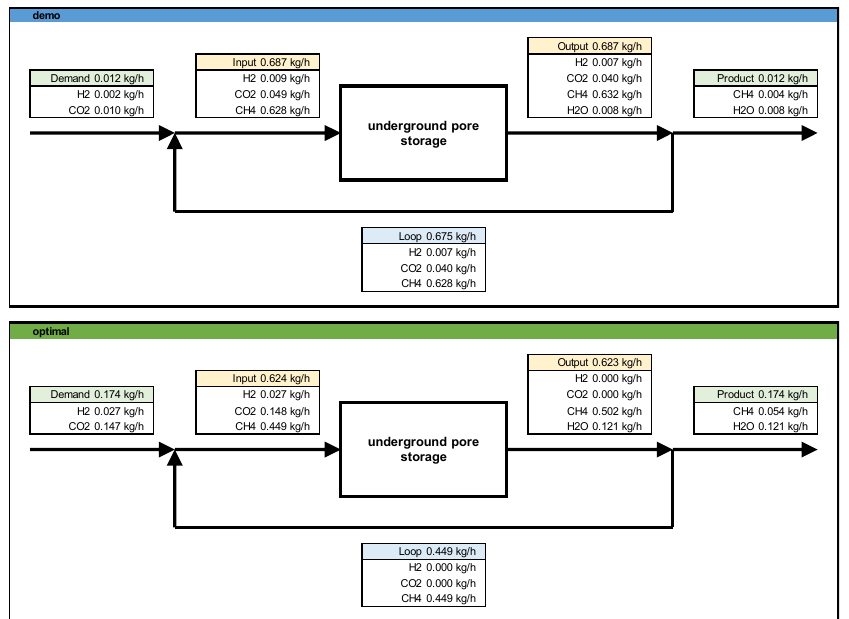
CH 4 Figure 6. System boundary for the LCA of the Underground Sun Conversion process using the example of the advance scenario. Figure 6 shows the applied “cradle-to-gate” system boundaries without considering the end use of the produced geo-methane. The function of the system is to produce synthetic methane from H 2 and CO 2 . Accordingly, the functional unit is 1 MJ CH 4 produced within the geo-methanation process. Carbon dioxide as a by-product of ammonia production is assumed to be the external carbon source in order to reflect the industrial CCU use case also applied in techno-economic analysis. The geographic